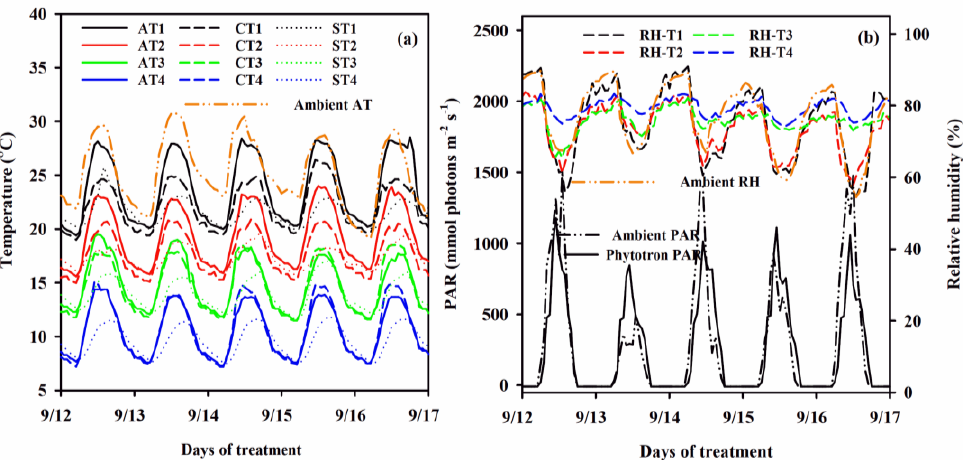
Figure 8. The ( a ) diurnal air (solid lines), canopy (broken lines) and soil temperatures (dotted lines) and ( b ) relative humidity (RH) (broken lines) and incident photosynthetically active radiations (PAR) (solid line) during low temperature treatment episodes in the phytotrons. Double dotted lines represent the ambient AT, PAR and RH of the same days.